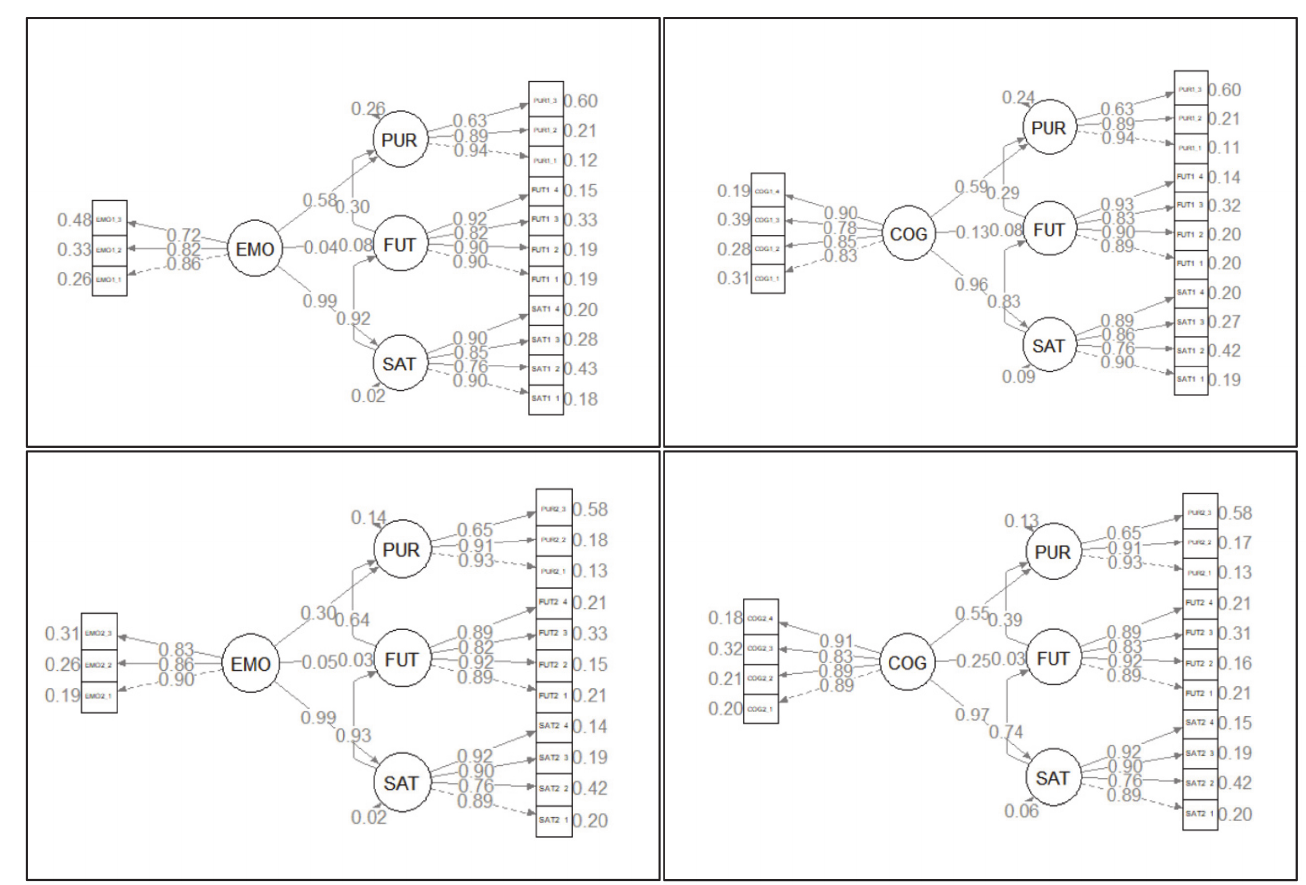
<Figure 8> Path models of the before personalization/after